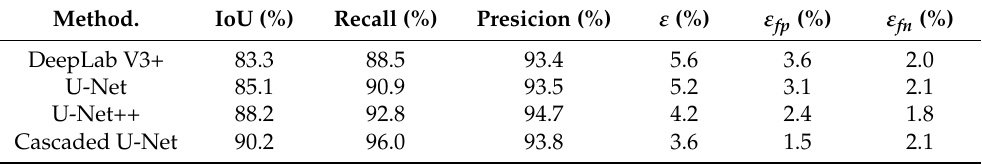
Table 5. Comparison of six indicators between our model and three other models.